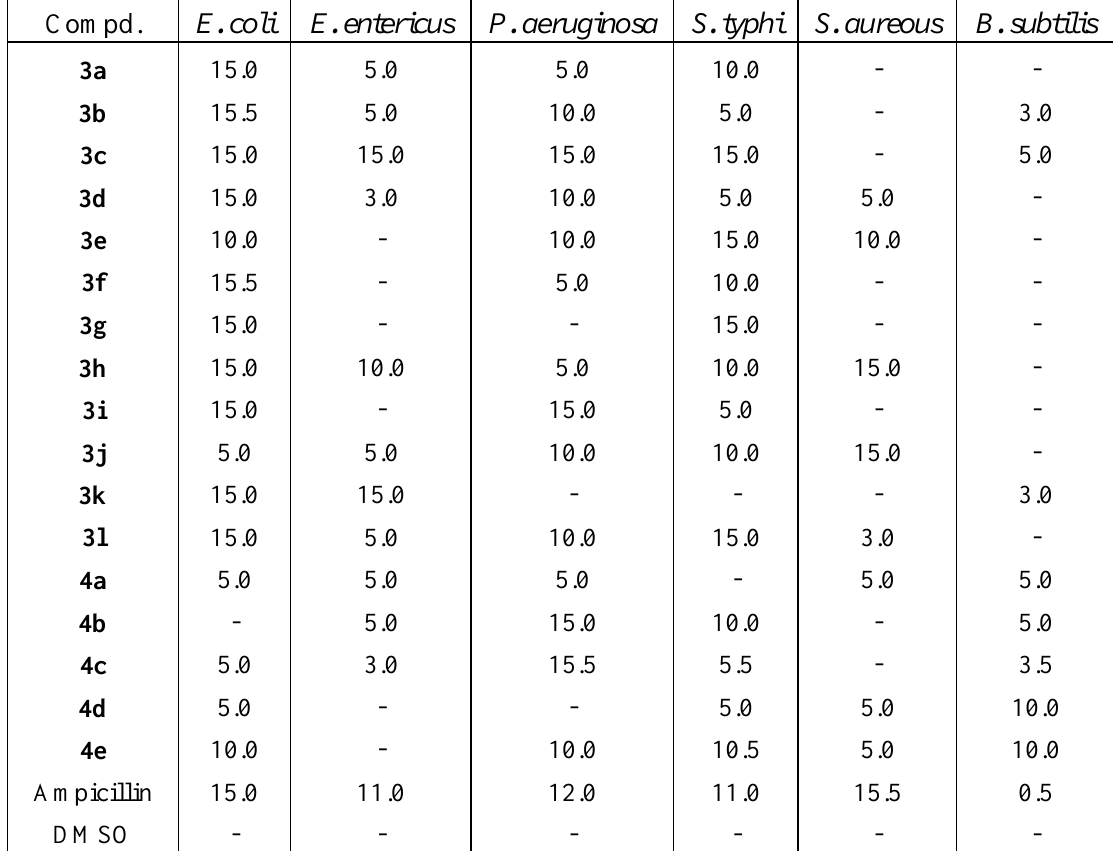
Table 1 : Antibacterial activity data of compounds 3 and 4 . Inhibition in mm after 48 hr